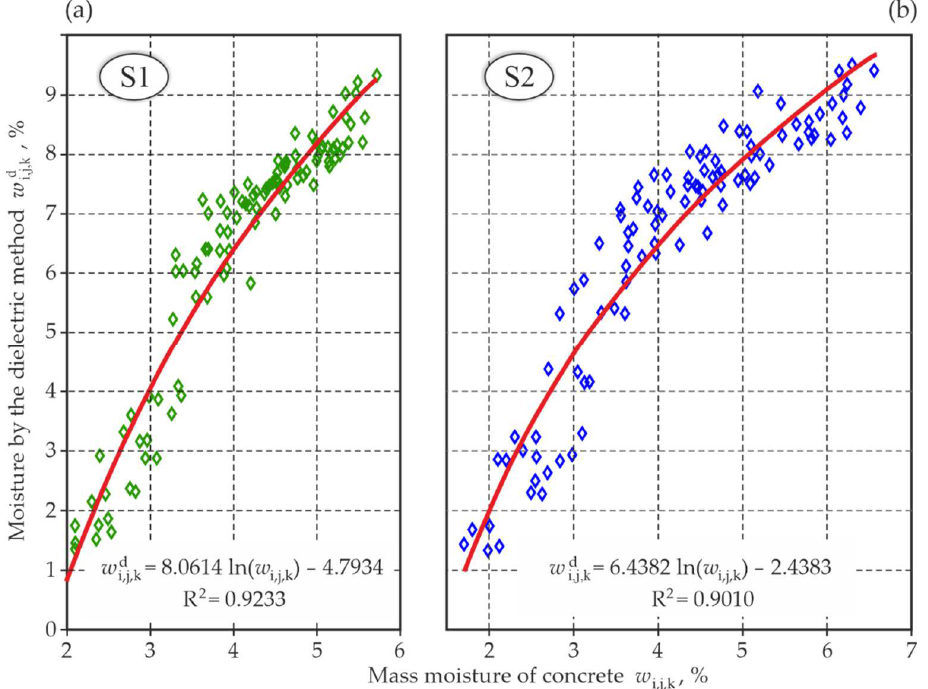
Figure A3. Results from correlation tests between the measurements of moisture content by the drying and weighing method and the dielectric method: ( a ) concrete with the best protective properties—series S1 , ( b ) concrete with chlorides and reduced protective properties—series S2 .